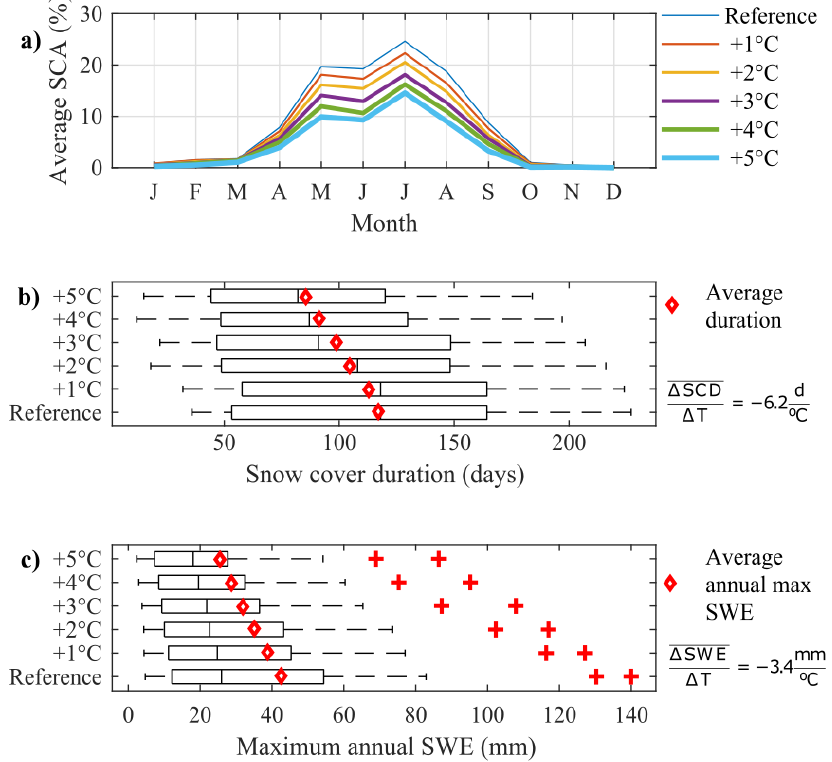
Figure 11. Sensitivity analysis to warmer conditions of the monthly fractional snow cover area ( a ), annual snowpack cover duration (SCD, panel ( b )) and maximum annual snow water equivalent (SWE) ( c ). The increment in temperature was in respect to the reference period between April 2001 and 1 April 2016. For the panel b and c, the slope was estimated using the average duration (“diamond symbols”, − 6.2 d ◦ C − 1 ) and average annual max SWE ( − 3.4 mm C − 1 ), respectively. The cross marks (+) represent the outliers of the